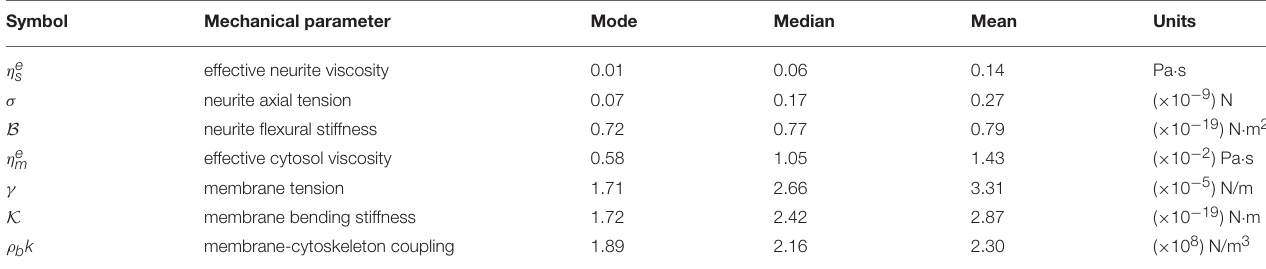
membrane bending stiffness membrane-cytoskeleton